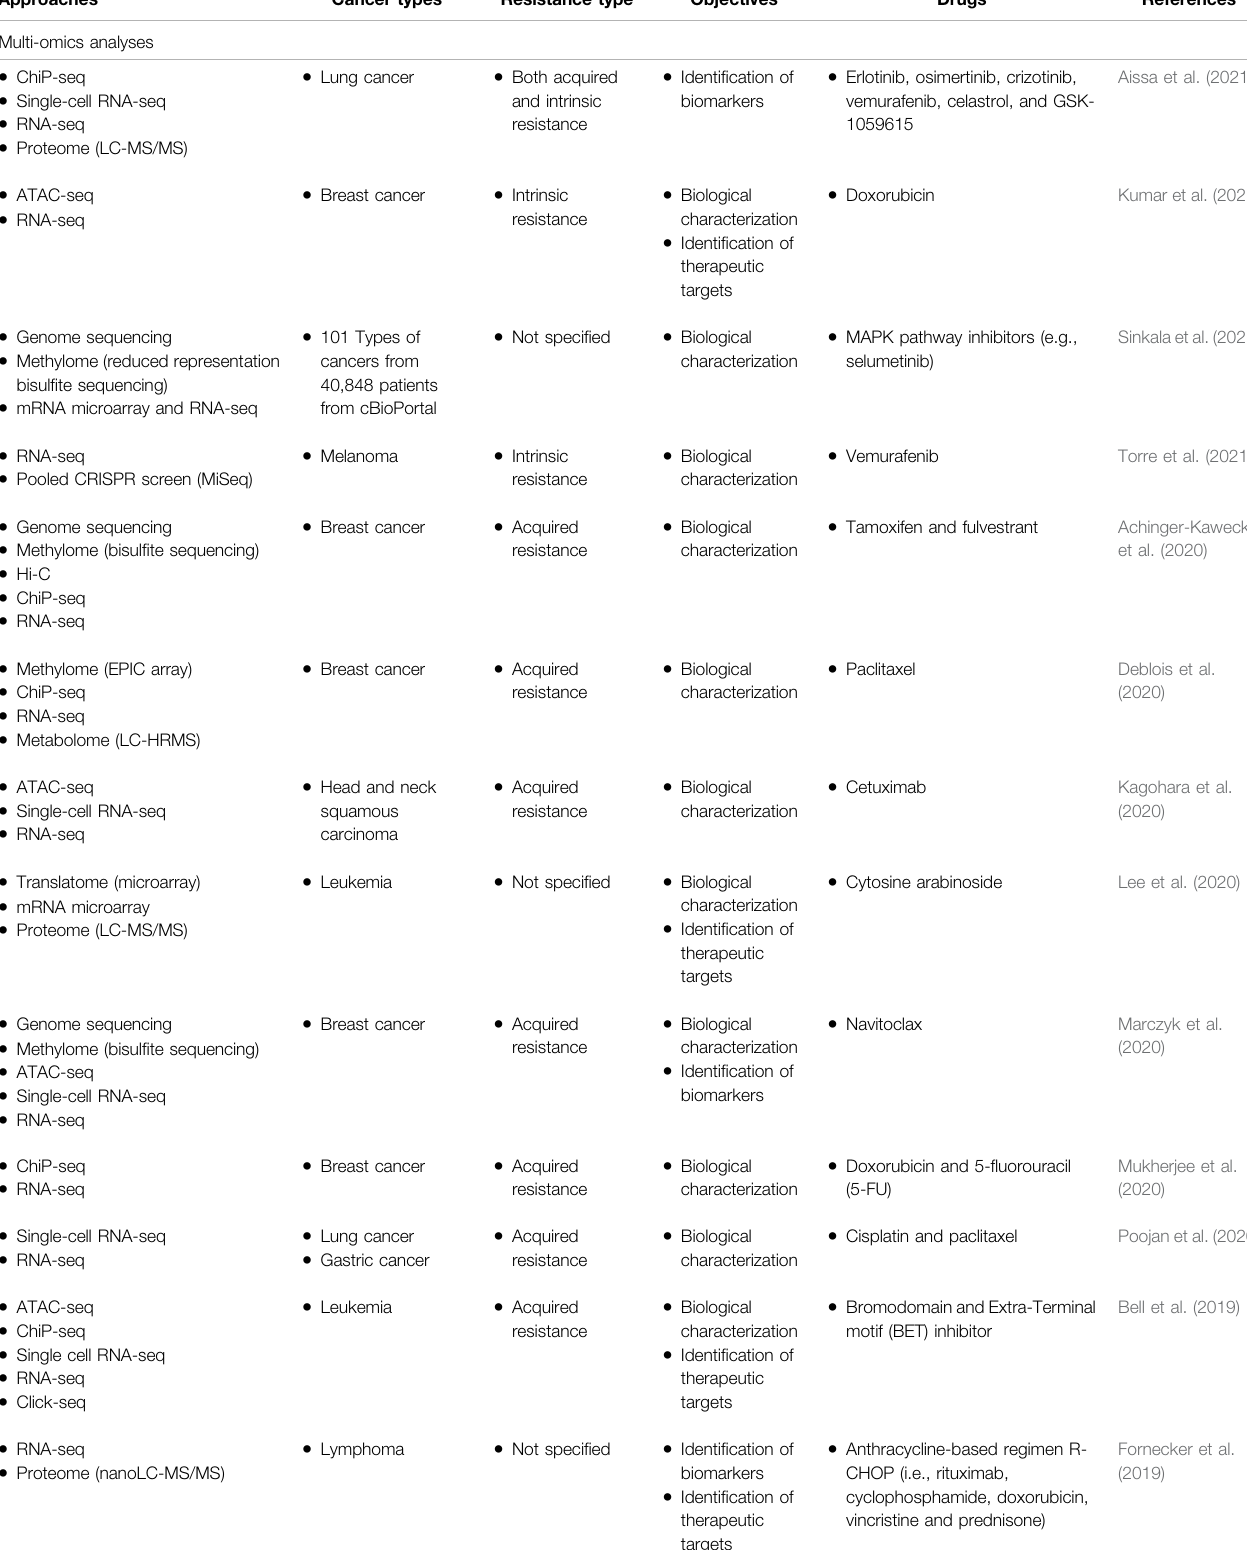
TABLE 1 | Recent studies on the use of omics data and computational models to better understand and treat drug-resistant cancer cells.